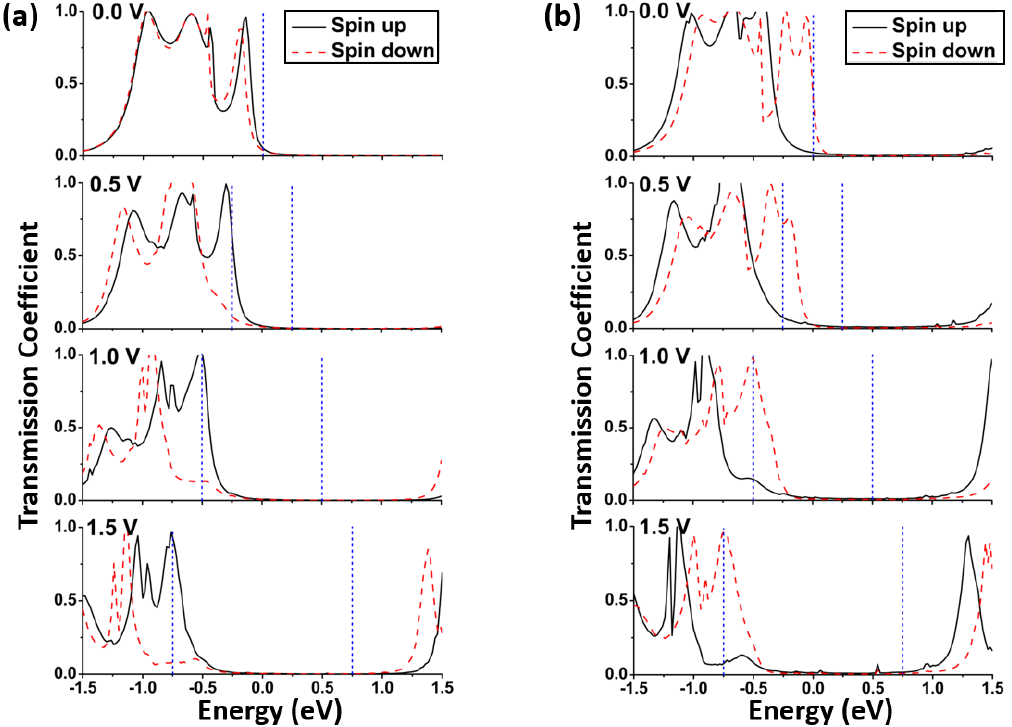
Figure 4. Spin-up and spin-down transmission spectra at the different biases for two models: ( a ) M1; ( b ) M2. The region confined by the two blue vertical dashed lines is the bias window.